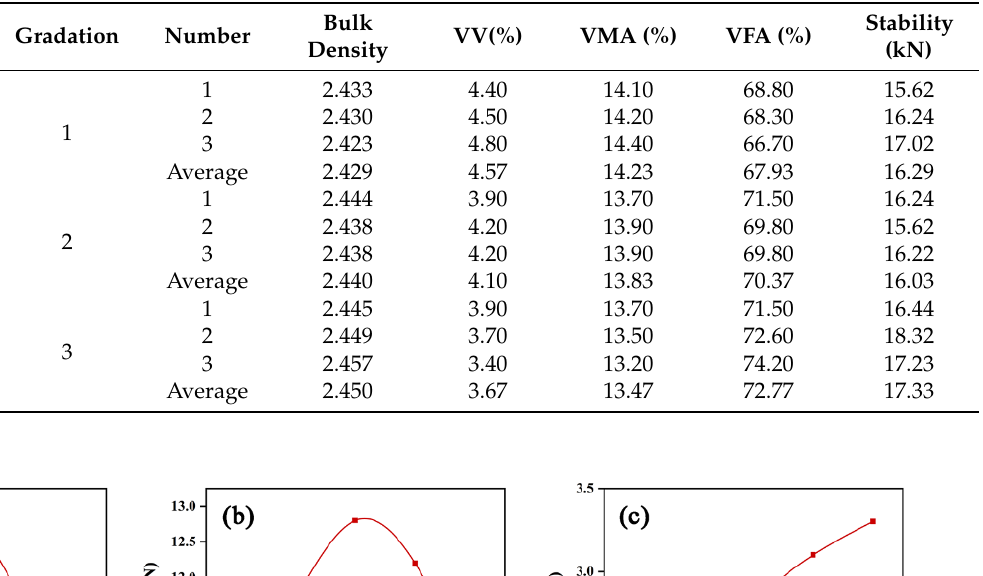
Table 11. Results of Marshall test of 3 gradations.